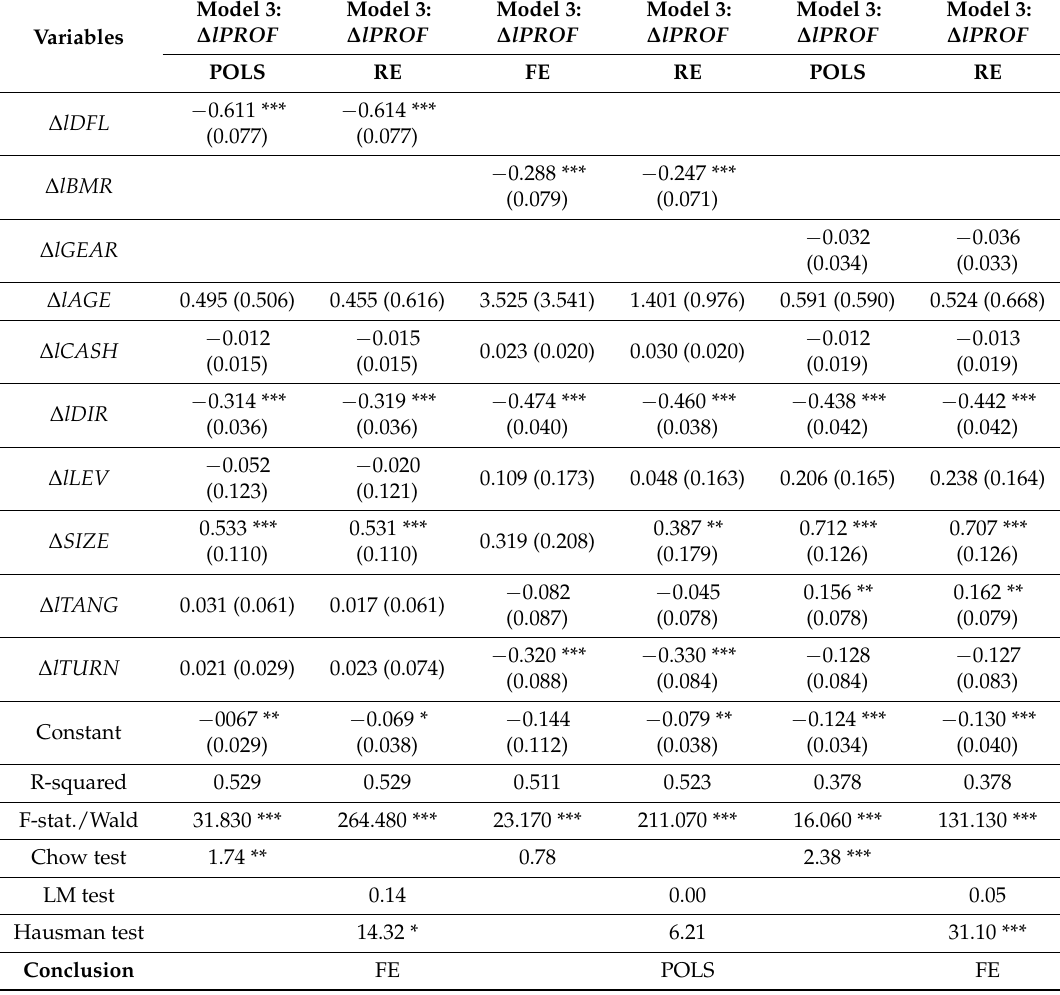
Table A8. Selection of the most appropriate estimator for the robustness analysis (Model